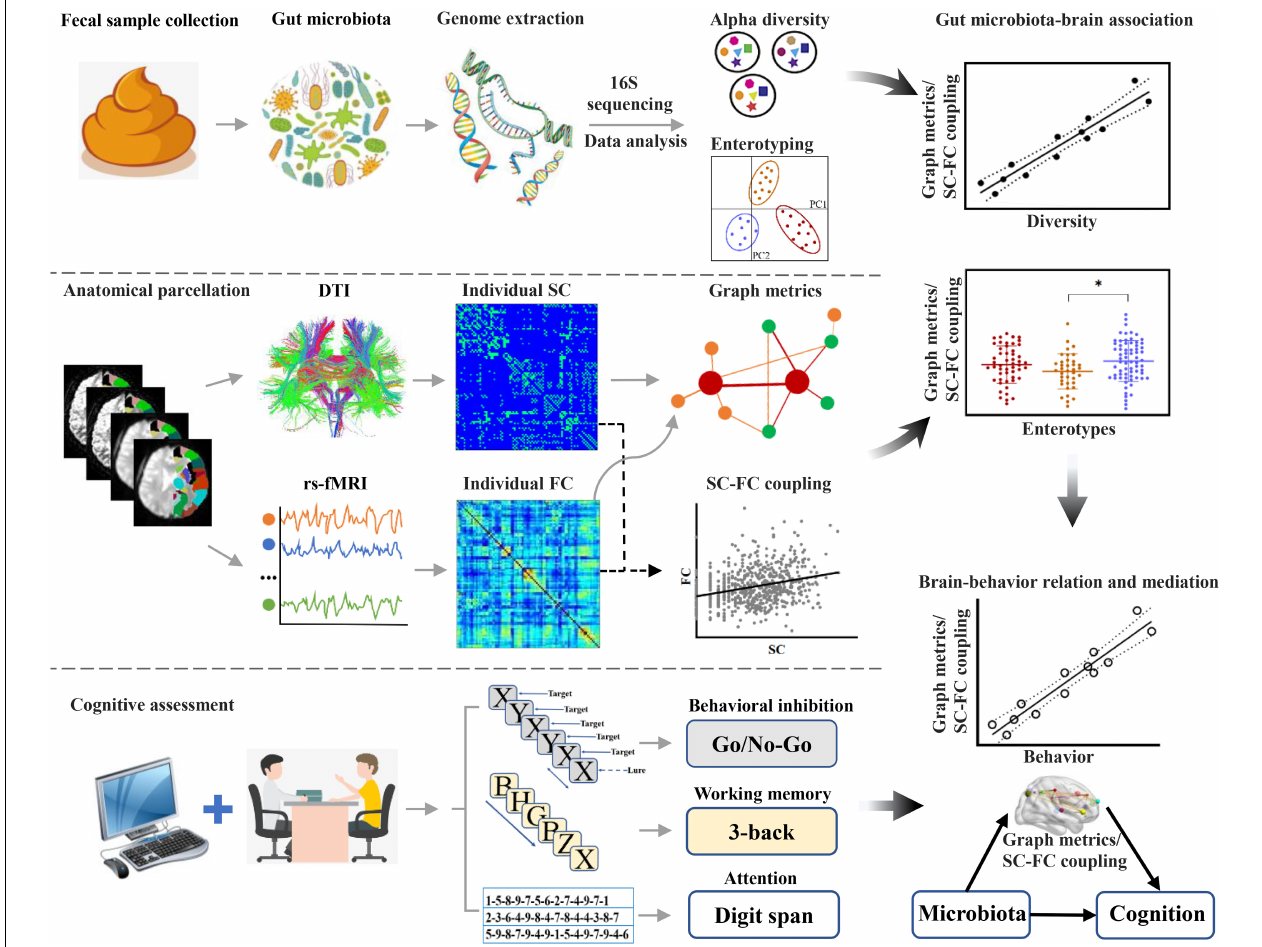
FIGURE 1 | Flowchart of the study design. DTI, diffusion tensor imaging; FC, functional connectivity; rs-fMRI, resting-state functional magnetic resonance imaging; SC, structural